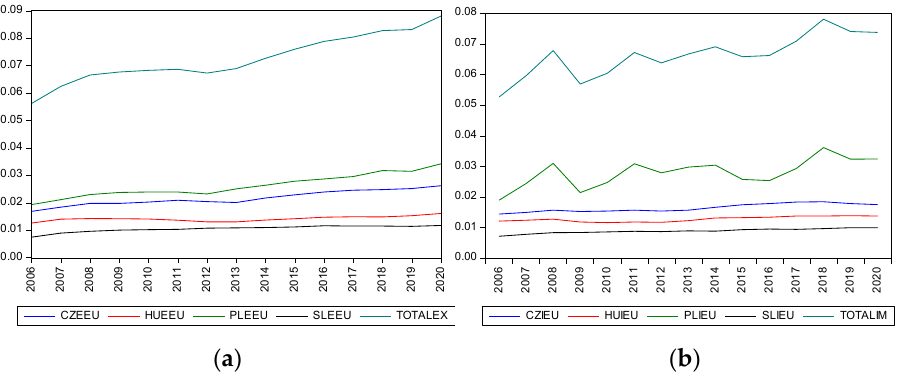
Figure 1. ( a ) Export Variables, ( b ) Import Variables. Trade ratio of V4 members. CZEEU: the Czech